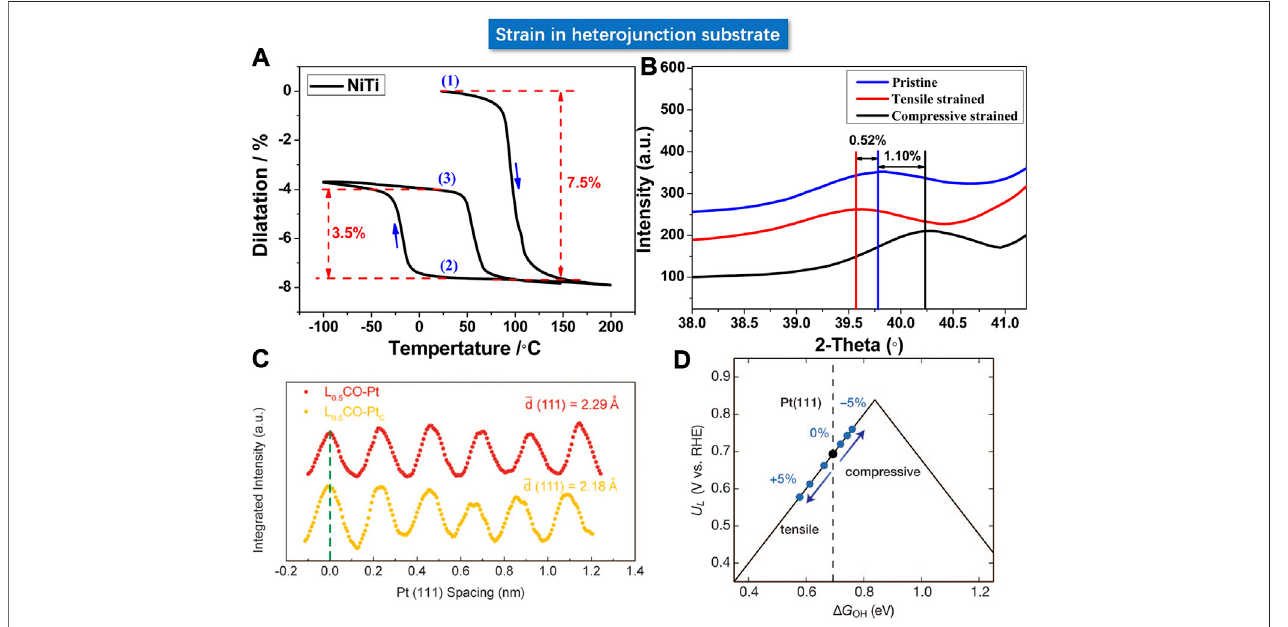
FIGURE12|(A) Deformationofshape memoryalloy NiTi under differentthermalcyclingtreatments. (B) Variation ofstrainonPt fi lm. (C) Lattice spacingofPt(111) crystallographicfacetundercharge(red)anddischarge(yellow)respectively. (D) Volcanicrelationshipbetweenactivityandstrainbasedontheexperimentalresult. (A,B) Reproduced with permission (Du et al., 2015). Copyright 2015, American Chemical Society. (C,D) Reproduced with permission (Wang et al., 2016). Copyright 2016, American Association for the Advancement of